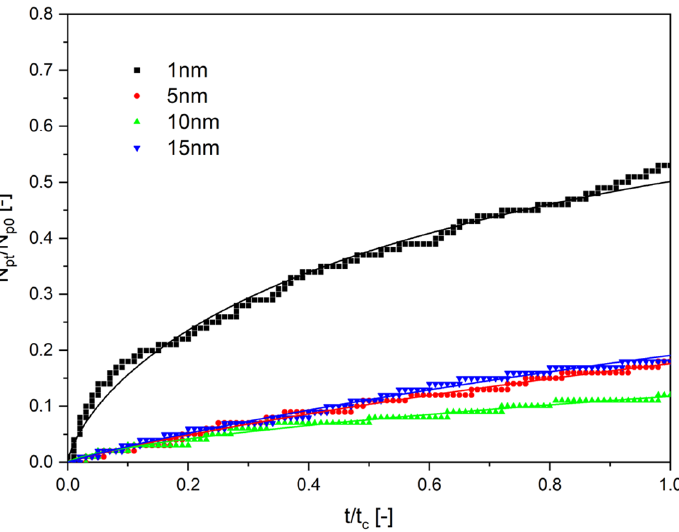
Figure 6. The dependence on the normalized number of particles as a function of normalized time. The viscosity of the liquid was 50 mPa·s for particles of different diameters.